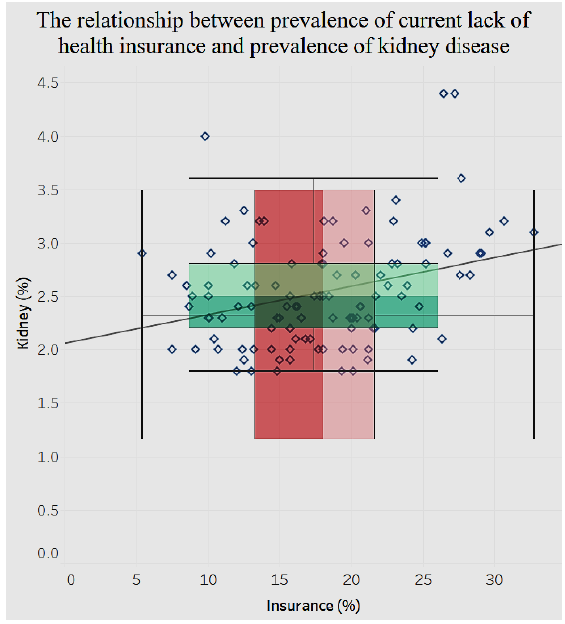
Figure 21. Lack of insurance by chronic kidney disease.